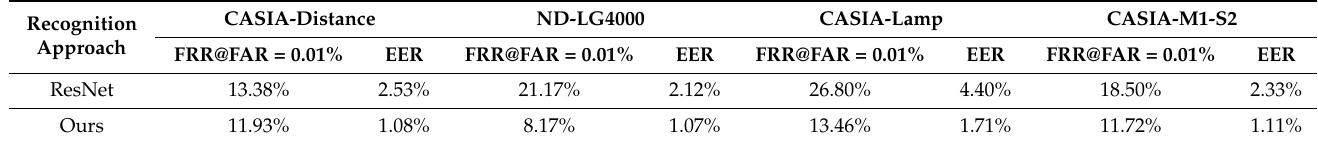
Table 3. Performance of the proposed network and ResNet.